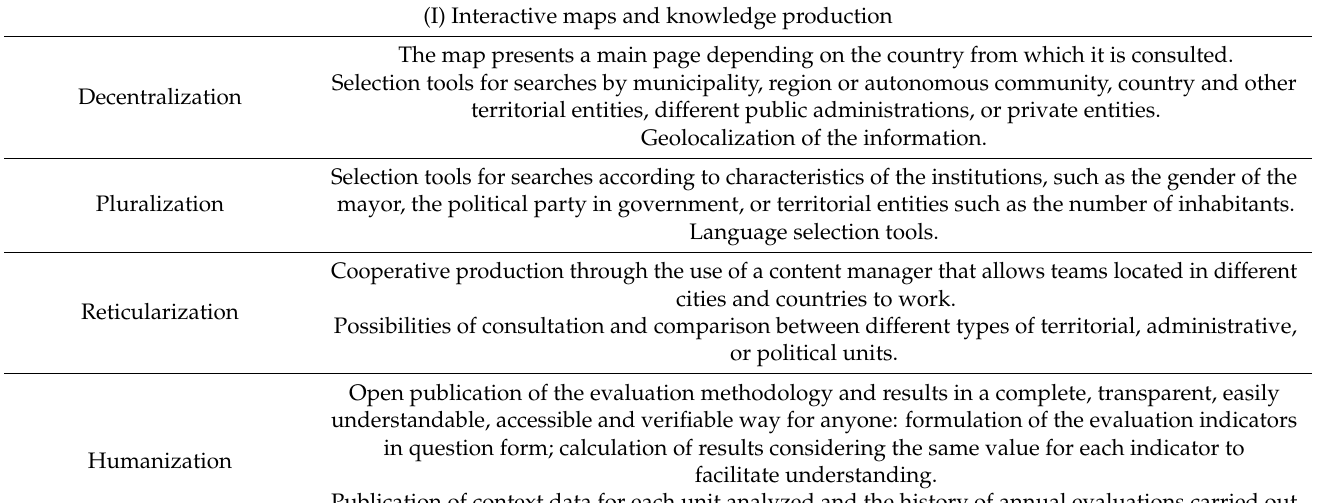
Table 2. Characteristics of the Mapa Infoparticipa. (I) Interactive maps and knowledge